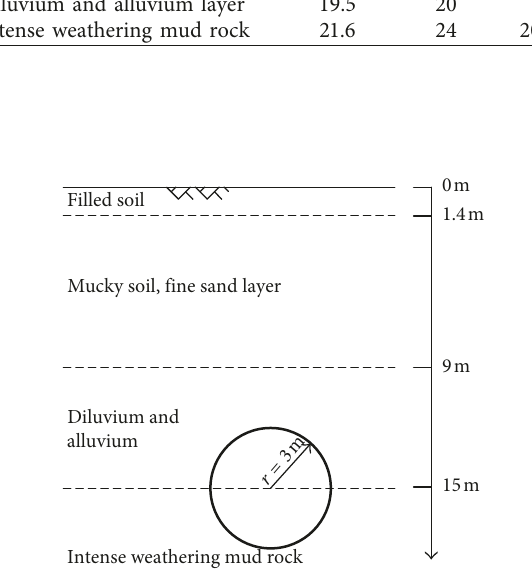
Figure 10: Tunnel depth and strata distribution for